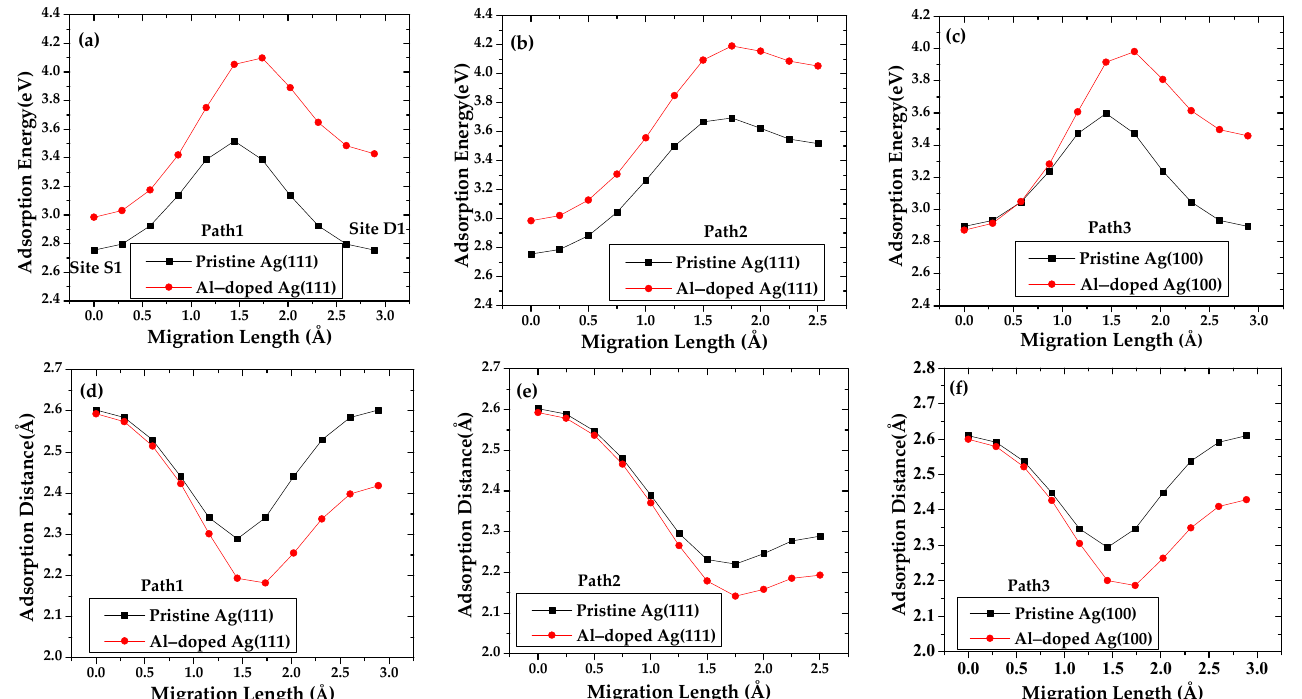
Figure 7. Adsorption energy of silver adatom migration pristine Ag (111)/Ag (100) surface and Al-doped Ag (111)/Ag (100) surface along ( a ) path 1, ( b ) path 2 and ( c ) path 3, and corresponding adsorption distances of silver adatom migration are represented by ( d ) path 1, ( e ) path 2 and ( f ) path 3.